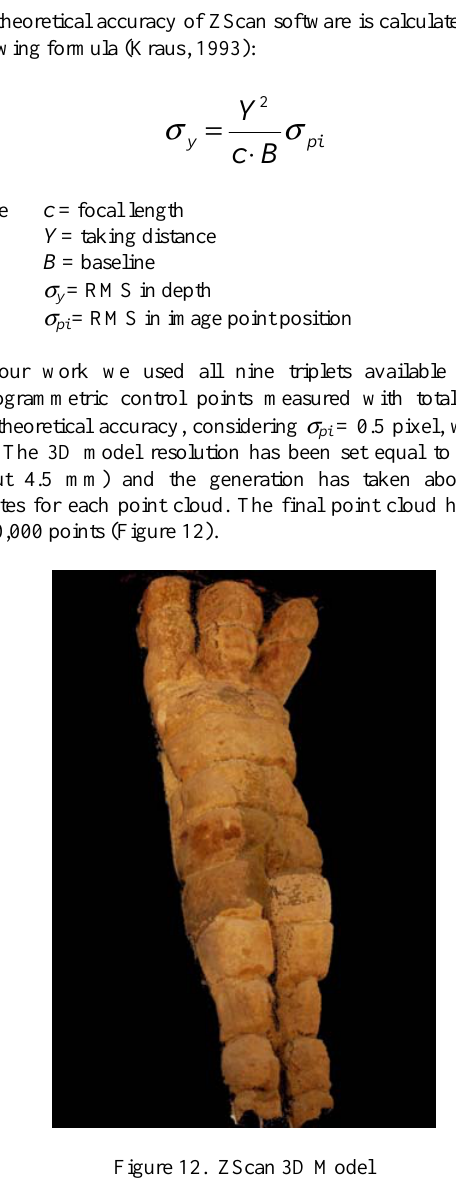
Figure 11. Screen-shot of ZScan software